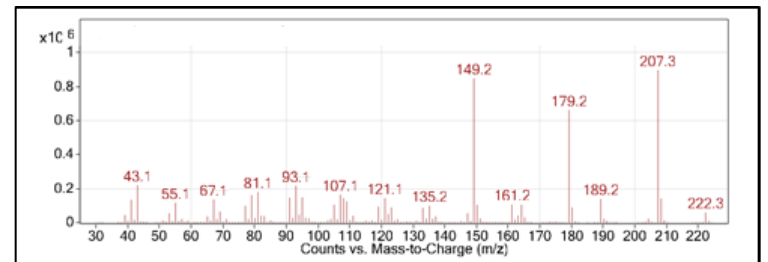
Figure 3. Mass spectrum of compound 2 .